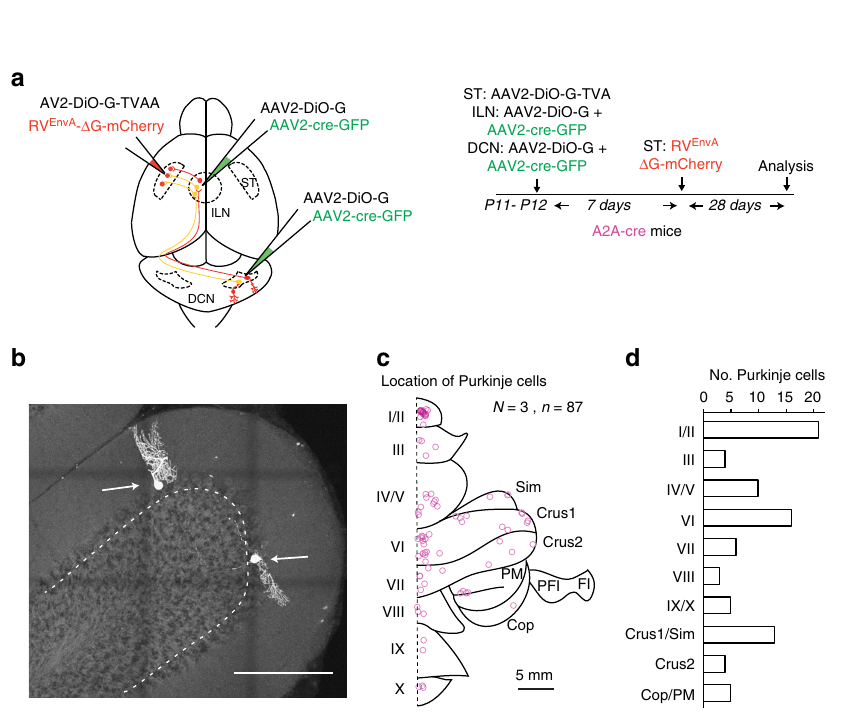
Fig. 3 Cerebello-striatal connectivity to MSNs and ChAT interneurons. a Stereotaxic injection and analysis scheme for multisynaptic tracing. Injections in D1R-cre ( N = 3), A2A-cre mice ( N = 9) and ChAT-cre mice ( N = 7) are initiated at P11-P12. First, AAV2-DiO-G-TVA is injected into the dorsal striatum (ST). This results in cre-dependent expression of viral Glycoprotein (G) and the surface receptor TVA in D2R-positive or ChAT-positive striatal cells. At the same time, AAV2-DiO-G and AAV2-cre-GFP are injected into the intralaminar thalamic nuclei (ILN) to express glycoprotein in ILN neurons (see Supplementary Figs. 3 and 4 for additional information on relay cells and RV-G expression). Seven days after the fi rst injection, EnvA-pseudotyped, glycoprotein-de fi cient rabies viruses are injected into the dorsal striatum. Five dorsal – ventral (DV) planes (plane 1, 2, 3, 4, 5) used for analysis illustrated. b Retrogradely labeled DCN neurons are registered at four dorsal – ventral planes. Cells obtained by back-labeling in D1R-cre, A2A-cre, and ChAT-cre mice are color-coded blue, magenta, and black, respectively. Data derived from tracings performed in N = 3 D1R-cre mice, N = 7 A2A-cre mice, and N = 7 ChAT-cre mice. Scale bar: 1 mm. c – e Morphology of DCN neurons retrogradely labeled in D1R-cre, A2A-cre, and ChAT-cre (arrows). Camera lucida drawings of example cells (arrows) reveal columnar and multipolar neuron morphologies. Scale bars: 500 µ m and 100 µ m, respectively. f Subnuclei distribution of retrogradely labeled DCN neurons. Note the overall preference for interposed nuclei (IntA, IntP) and lateral dentate nucleus in D1R-cre, A2A-cre and ChAT-cre mice. Back-labeled DCN neurons in A2A-cre mice have preferential labeling in medial dentate nucleus when compared to ChAT- cre mice ( p < 0.05, chi-square test). N = 3 mice and n = 51 DCN cells for D1R-cre, N = 9 mice and n = 350 DCN cells for A2A-cre, and N = 7 mice and n = 226 DCN cells for ChAT-cre. Mean ± SEM